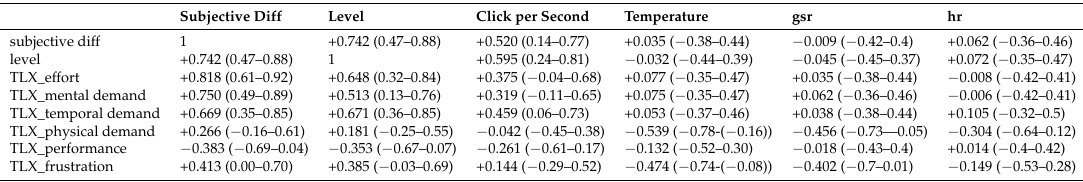
Table 6. Correlations between the TLX scores and the objective cognitive load measure for the Snake dataset with 95% confidence interval in